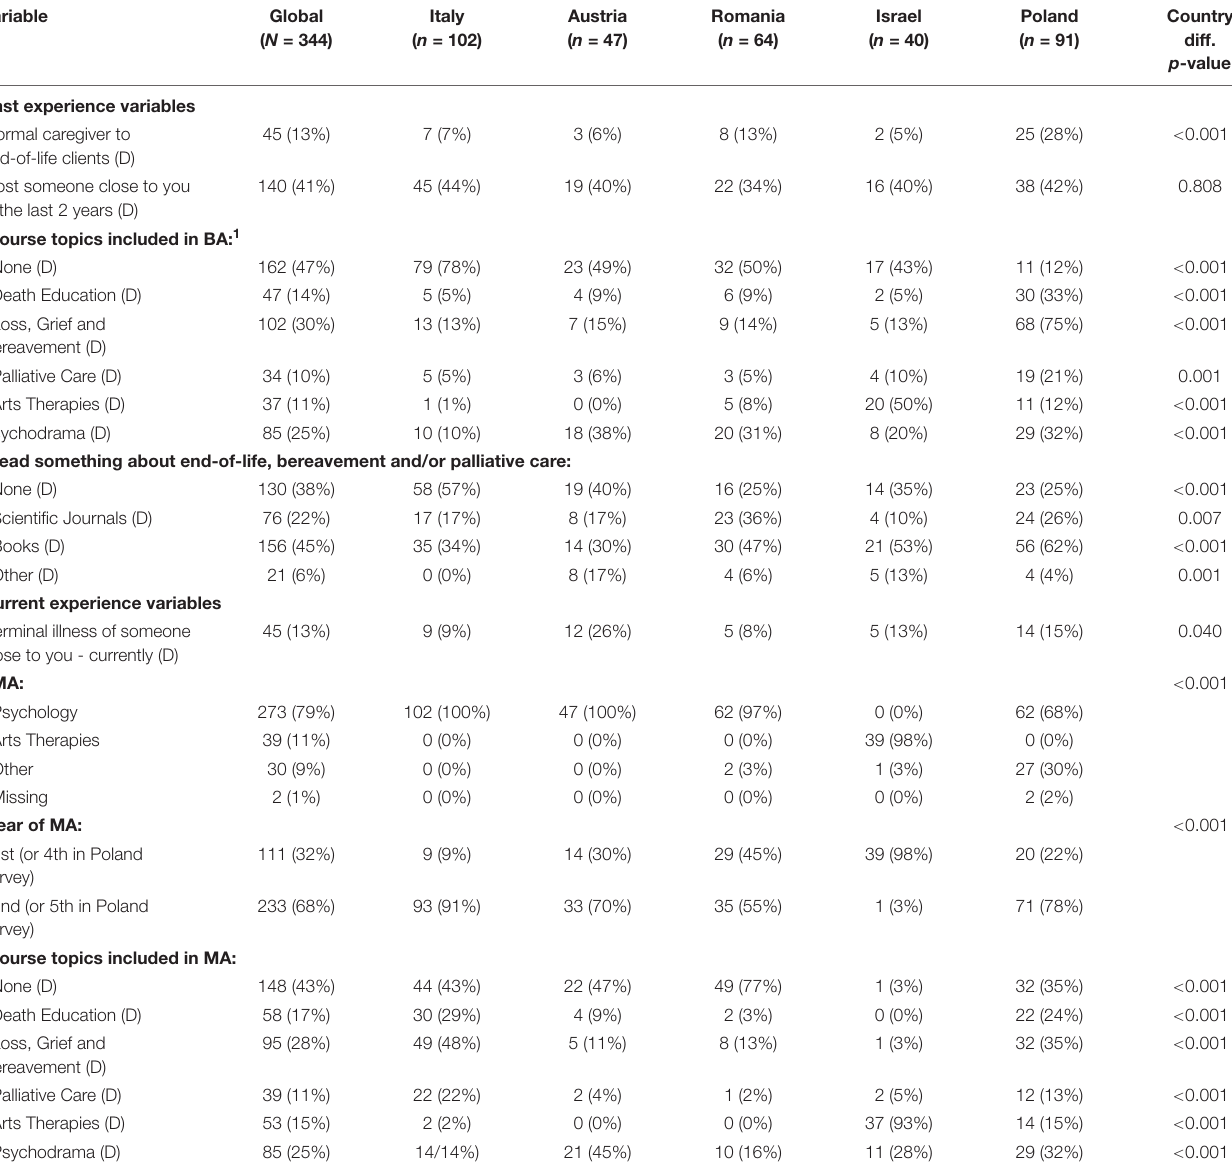
TABLE 2 | Descriptive statistics for the student experience variables and differences between countries for each variable. Variable Global